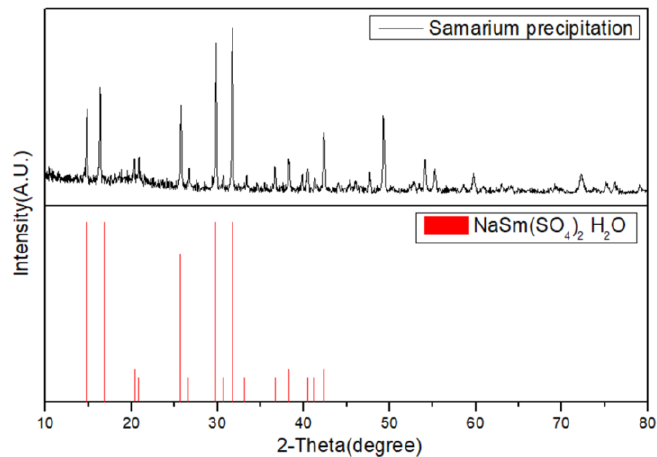
Figure 4. Effects of ( a ) Na 2 SO 4 to Sm molar ratio, ( b ) temperature at Na 2 SO 4 :Sm ratio of 4:1, and ( c ) time for the Sm precipitation at Na 2 SO 4 : Sm ratio of 4:1.